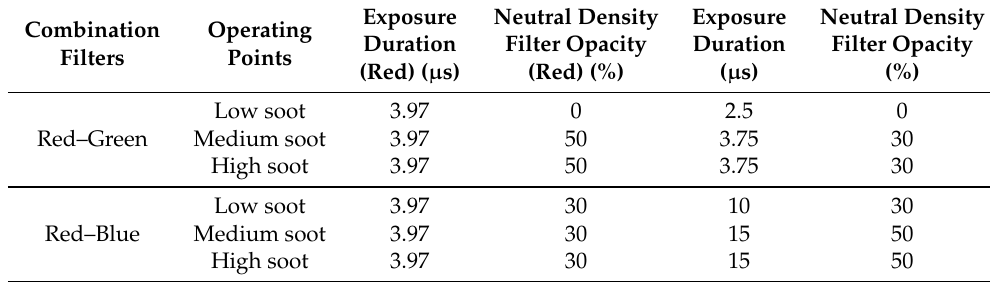
Table 5. Interference filter influence test matrix.